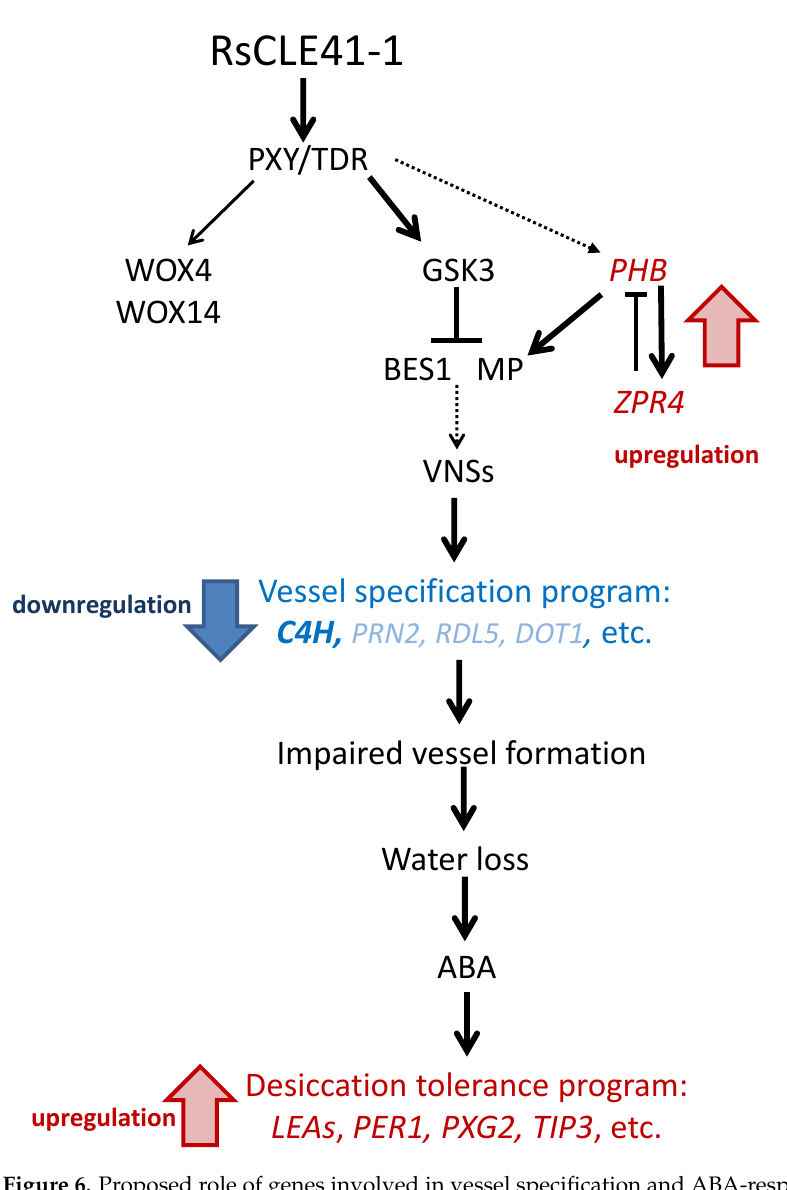
Figure 6. Proposed role of genes involved in vessel specification and ABA-responsive genes which provide desiccation tolerance in the late embryogenesis in the development of 35S:RsCLE41-1 roots.